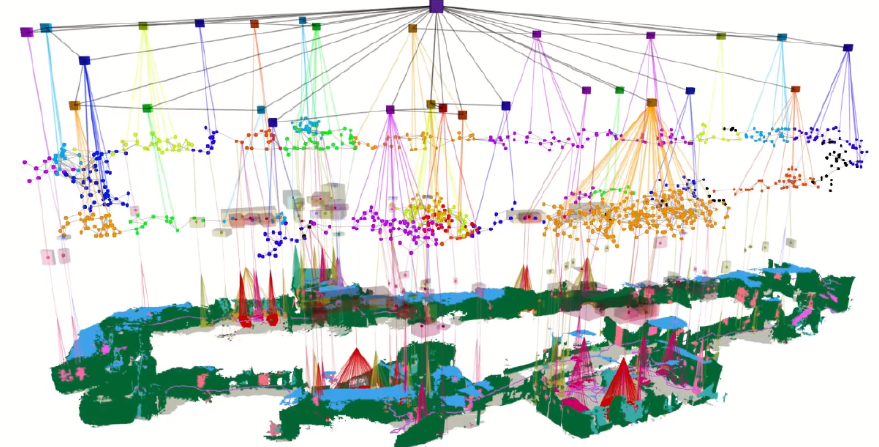
Figure 5. Using Dynamic Scene Graph (DSG) [85] for generating multi-layer abstraction of an indoor